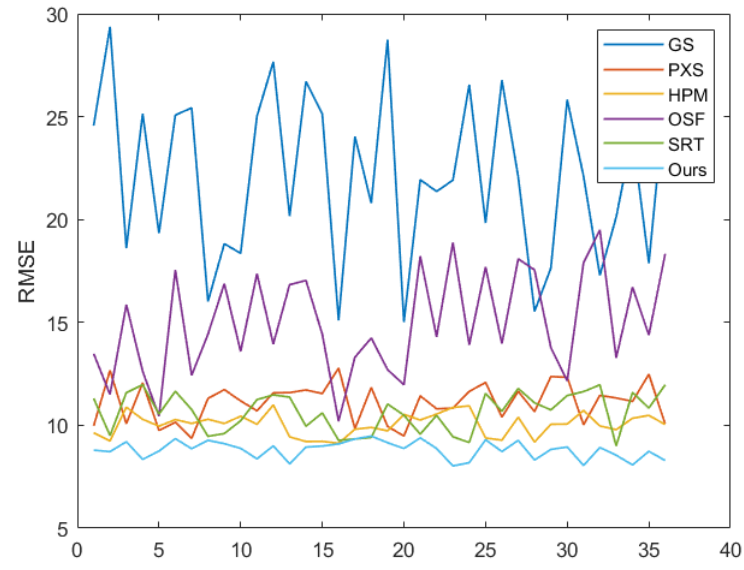
Figure 6. Comparison of RMSE results of different algorithms on simulation data.